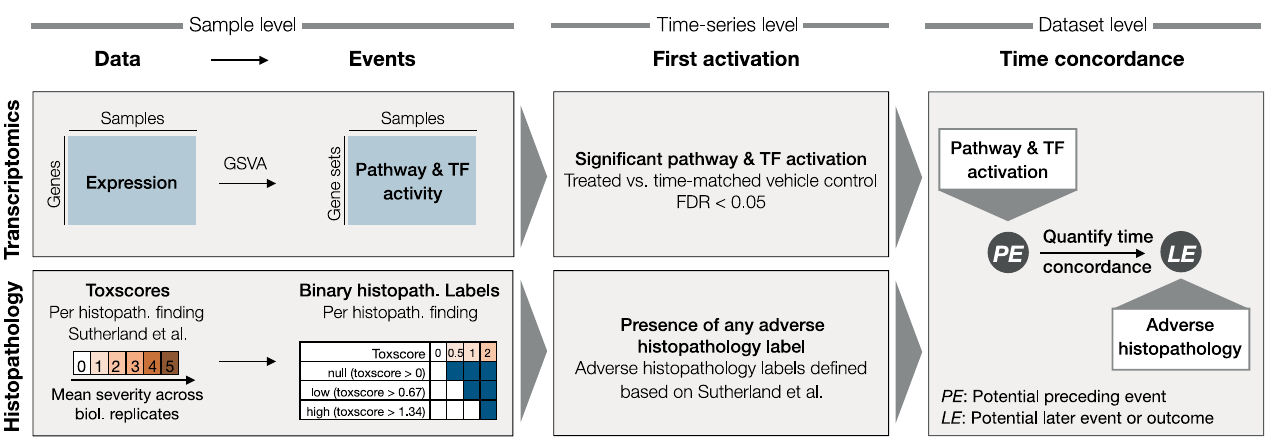
Fig 2. Workflow to quantify time concordance between preceding gene expression-derived events and later adverse histopathology. First, events are derived from the gene expression and histopathology data. Pathway and TF activity is inferred based on the expression of the respective gene sets using GSVA [26] and binary histopathology labels are derived from the continuous toxscores. Secondly, we derive the first activation of expression-based events as well as of adverse histopathology. Lastly, we quantify the time concordance between potential preceding events (PE) which are derived from gene expression and adverse histopathology as potential later event (LE).